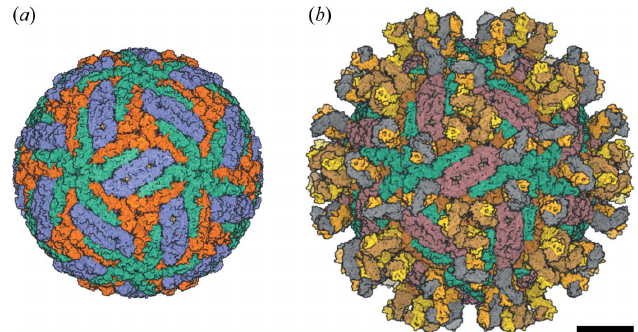
Figure 1 Cryo-EM structure of TBEV. ( a ) Structure of the mature TBEV particle 5o6a. ( b ) Structure of the complex with the Fab-fragment of the neutralizing monoclonal antibody 5o6v. The structures of TBEV were taken from the PDB (https://www.rcsb.org/). The scale bar is 10 nm.